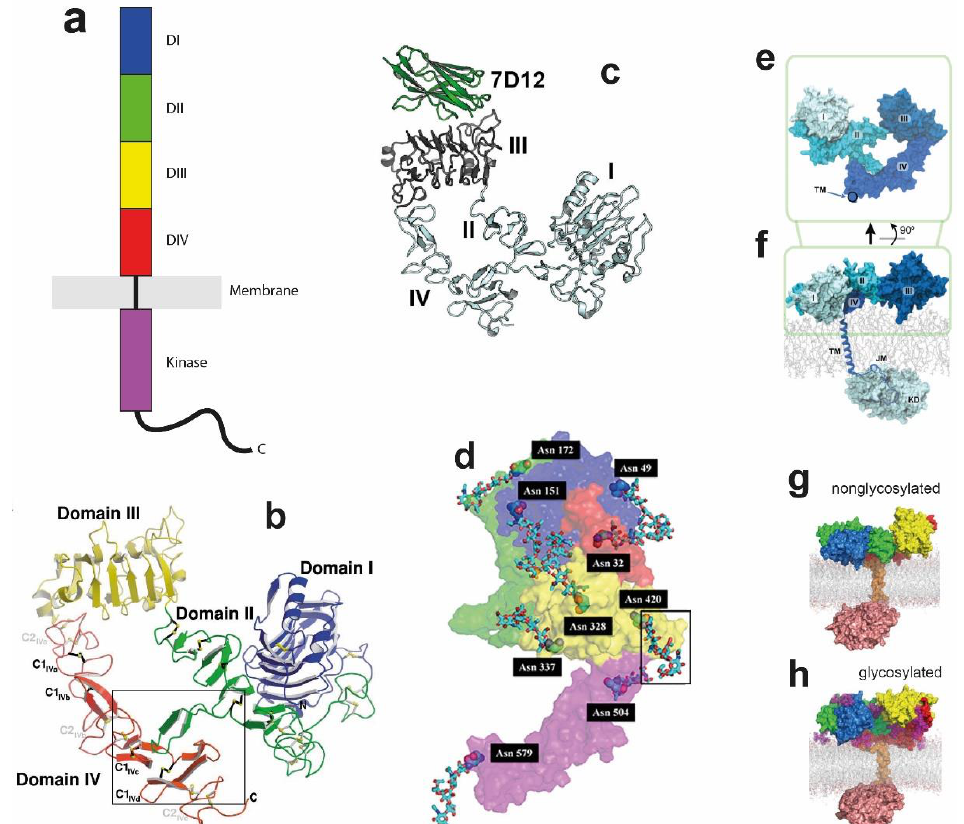
Figure 1. Topology, structure, and simulations of the epidermal growth factor receptor (EGFR) monomer. ( a ) Cartoon of an EGFR monomer, showing its domain structure. ( b ) Ribbon representation of the solubilised monomeric extracellular module (ECM) of EGFR (sEGFR) structure (Protein Data Bank (PDB): 1NQL), showing the “tether”, in which an α -hairpin from DII forms an interaction with DIV. Disulfidebondsarelabelledinblack(C1)andgray(C2). Taken, withpermission, fromFerguson et al.[85]. ( c ) Ribbon representation of sEGFR with bound VHH domain 7D12 (PDB: 4KRL), again showing the presence of the tether. Taken, with permission, from Schmitz et al. [89]]. ( d ) Extended monomer structure of EGFR (PDB: 3NJP), taking a monomer unit from the ligand-bound back-to-back dimer. The locations of glycosylated Asparagine residues are shown, one highlighted inside a grey box.